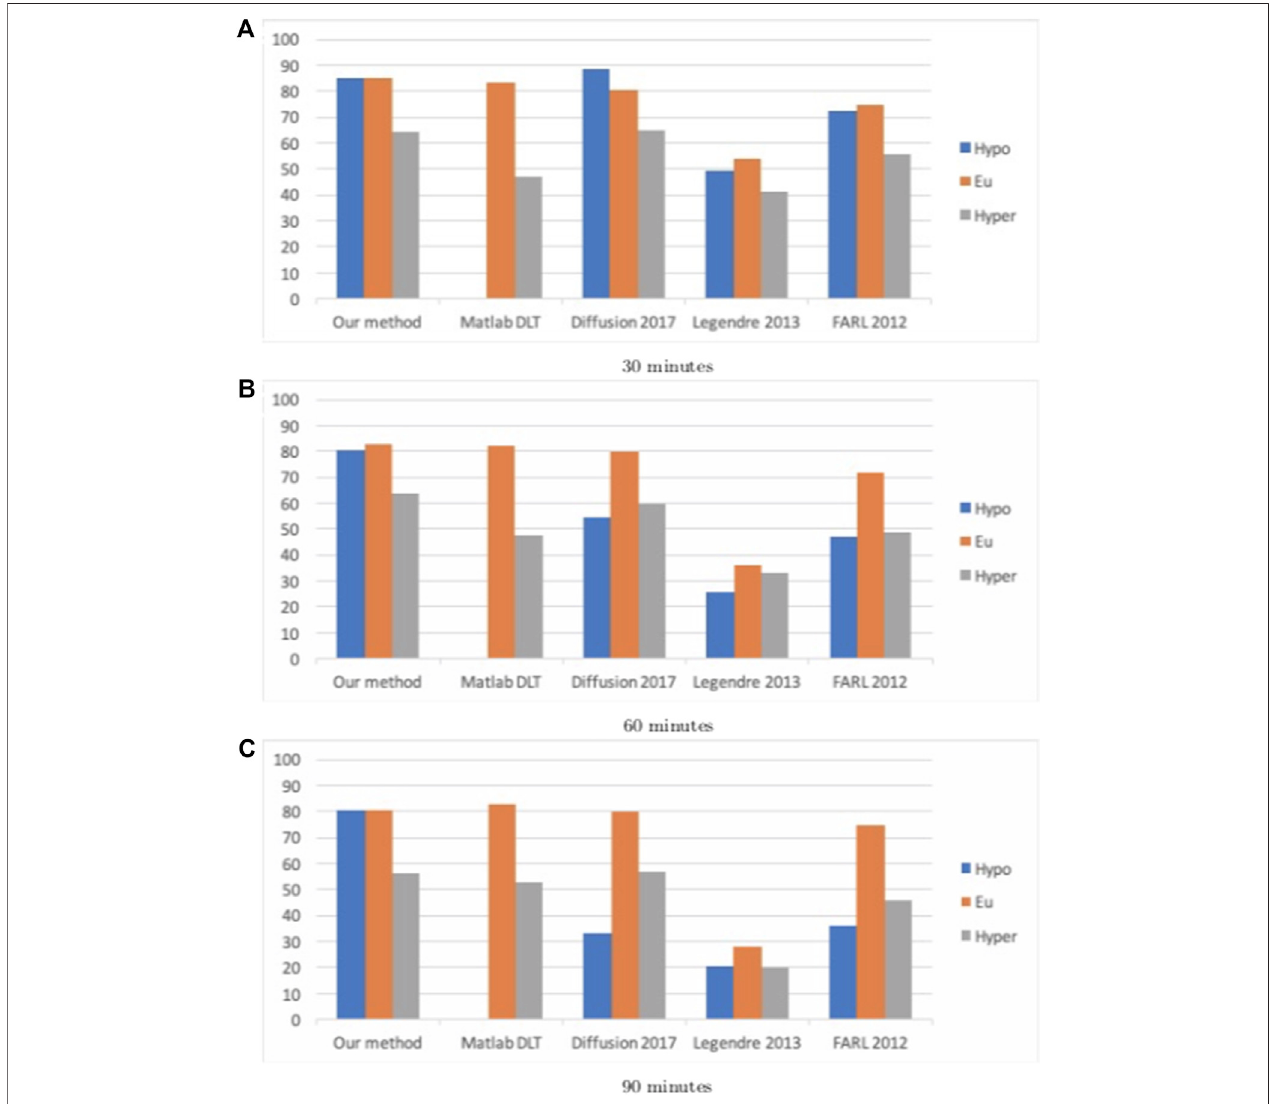
FIGURE 1 | Percentage accurate predictions and predictions with benign consequences in all three BG ranges (blue: hypoglycemia; orange: euglycemia; grey: hyperglycemia) for dataset D, for all fi ve methods for different prediction windows (30, 60, and 90 min).